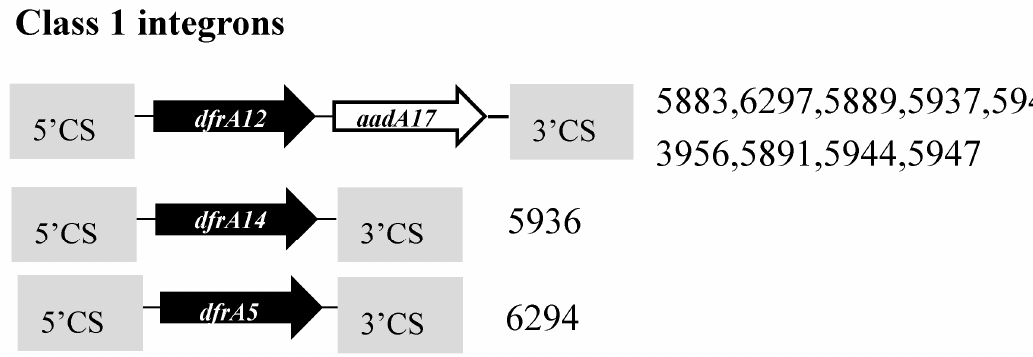
Figure 6. Schematic representation of the various gene cassette arrangements found in class 1 integrons detected in this study. The arrows display the open reading frames of the different genes. All aadA genes are presented as white arrows and dfrA genes as black arrows. The grey boxes indicate the 3’ and 5’ CSs regions typical of class 1 integrons harboring additional resistance determinants. On the right are the strains Ids containing the specific integron types. The gene cassettes are not drawn to scale.